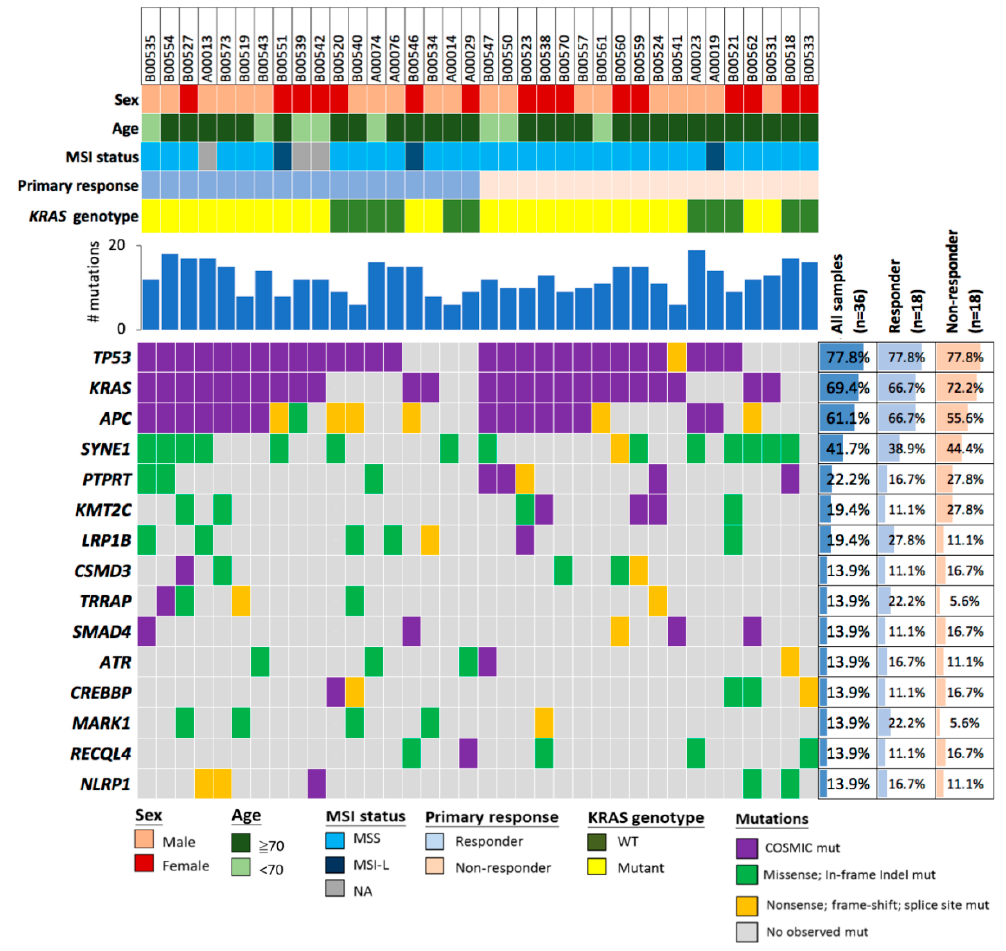
Figure 1. Mutations detected in tumor samples of colorectal cancer patients according to bevacizumab response status. Genes for which genetic mutations were detected in at least five study patients are depicted in an oncoprint plot and were ranked according to their observed mutation frequency in the overall study cohort. Patients were grouped according to their bevacizumab response status. Mutations were subdivided into variants with or without existing COSMIC ID. Variants without COSMIC ID were either truncating variants—including nonsense, frameshift, and splice-site variants or missense variants and in-frame indel variants. Additionally, the patient characteristics sex, age, MSI status, and total number of detected mutations are indicated for each patient.